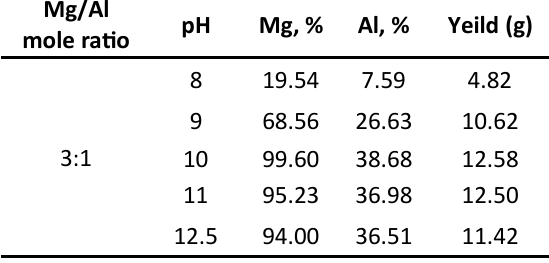
Table 1. Determination of Mg and Al ion by titration in Mg/Al